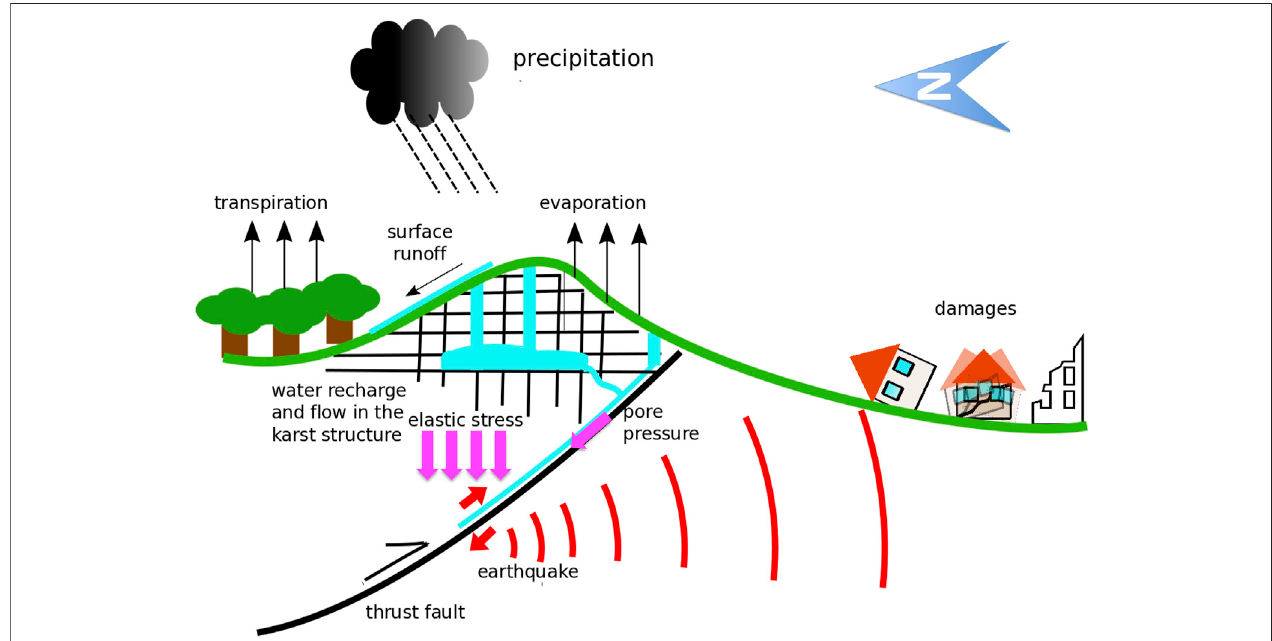
FIGURE 1 | Cycle of water and earthquake triggering in a karst environment: precipitation water recharges the karst network increasing elastic stress and pore pressure on faults. The fi gure depicts the tectonic setting typical of north-eastern Italy, with thrust faults dipping northwards under the Alpine-Prealpine belt.